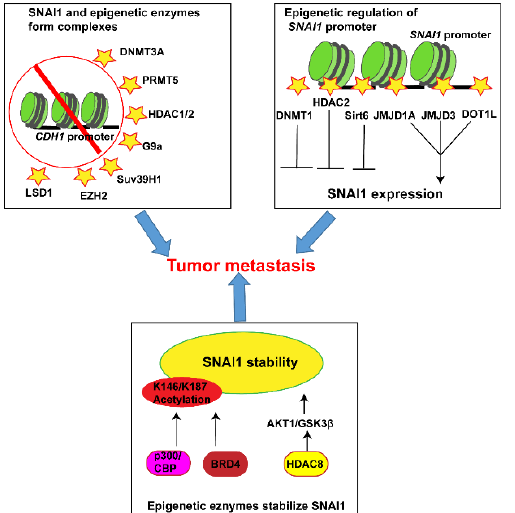
Figure 3. The interplay between SNAI1 and epigenetic regulators. SNAI1 collaborates with epigenetic regulators to repress CDH1 expression. Epigenetic regulators are recruited to the SNAI1 promoter, leading to transcriptional activation or repression of SNAI1. In addition, epigenetic regulators regulate SNAI1 stability by post-translational modifications. The increase in SNAI1 expression via multiple epigenetic mechanisms leads to the cancer metastasis that is accompanied by the loss of CDH1. DNMT: DNA methyltransferases; PRMT: protein arginine methyltransferases; HDAC: histone deacetylases; Suv39H1: suppressor of variegation 3-9 homolog 1; EZH2: enhancer of zeste 2 polycomb repressive complex 2 subunit; LSD1: lysine-specific demethylase 1; JMJD: Jumonji C domain-containing; DOT1L: DOT1 like histone lysine methyltransferase; BRD4: bromodomain-containing protein 4; CBP: CREB binding protein.